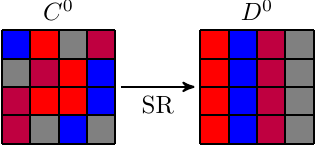
Figure 2: Illustration of the column mapping